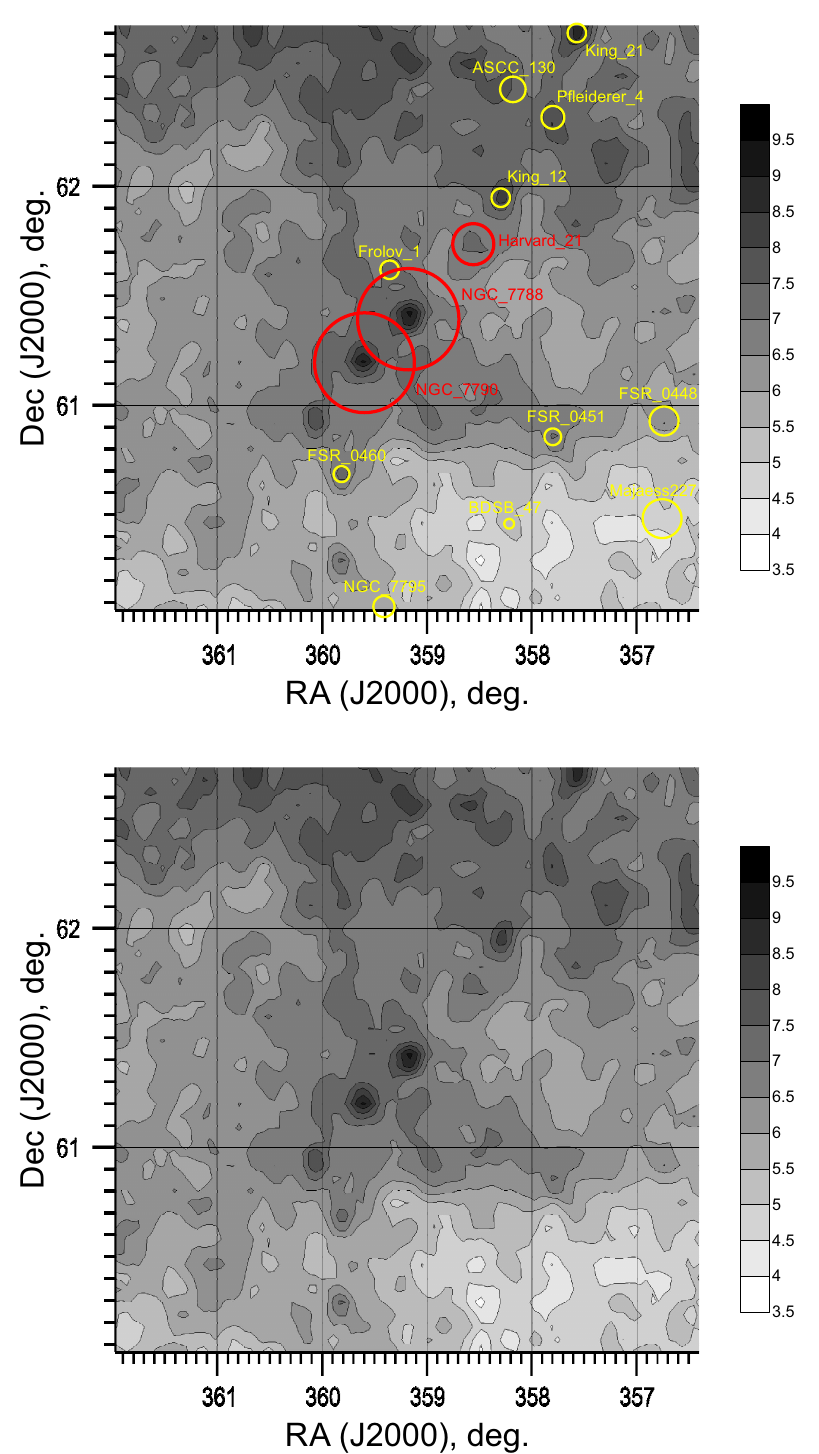
Figure 1. ( Upper panel ) The map of surface stellar density in the field centred on coordinates of star cluster NGC 7788. The map was plotted with the use of a kernel estimator (Seleznev 2016b) and using the data from 2MASS (Skrutskie et al. 2006) for stars with J<16 magnitudes and with a kernel halfwidth of 5 arcminutes. ( Lower panel ) The same map with overlapped positions and relative sizes of star clusters from the catalogue of Dias et al. (2014). Clusters marked by red have data on their sizes from the star counts of Danilov and Seleznev